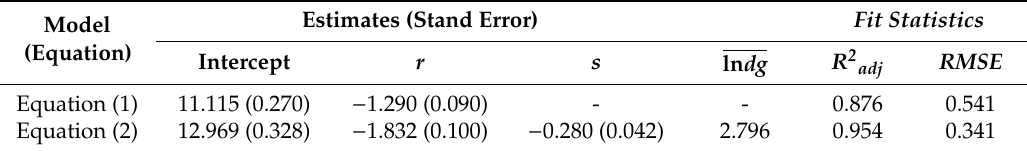
Figure 3. Diagram of dispersion and relationship between the logarithm of N (trees.ha − 1 ) and the logarithm of dg (cm) for the dataset of 30 border points. The straight line corresponds to the fitted linear model (Equation (1)) and the curve to the quadratic model (Equation (2)). Table 3. Coefficients (standard errors) and fit statistics of the estimated models to support the definition of the maximum size–density trajectory for maritime pine ( n = 30 observations). RMSE: root mean square error.